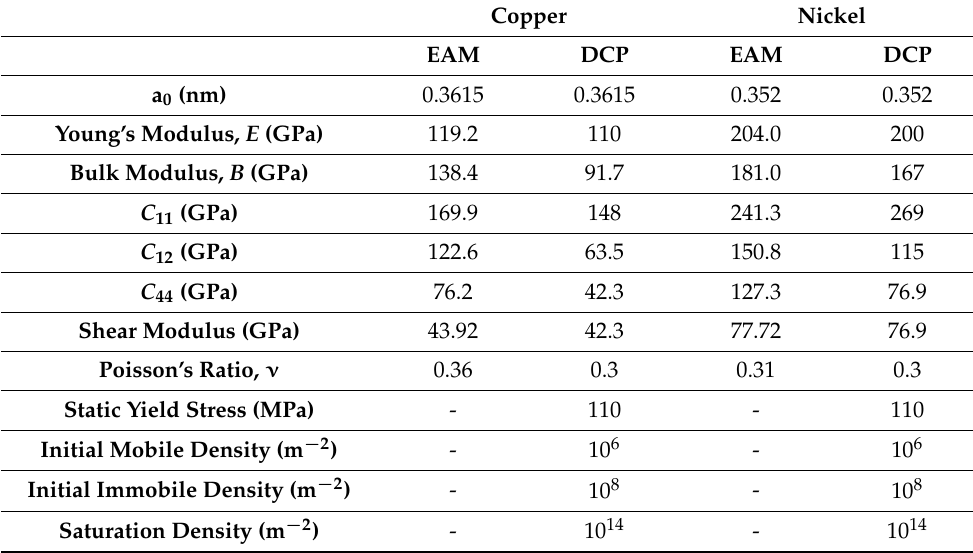
Table 5. Comparison of material properties.